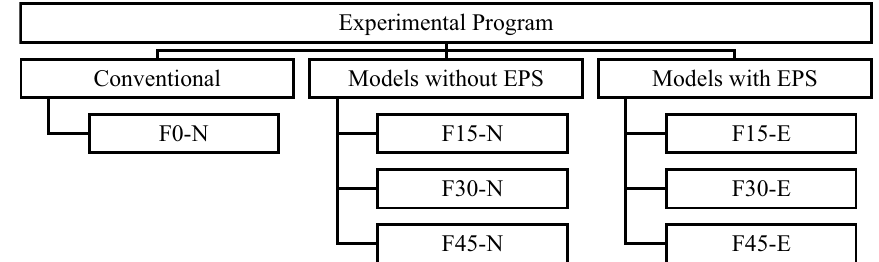
Fig. 1 Types and codes of footing models used in the study